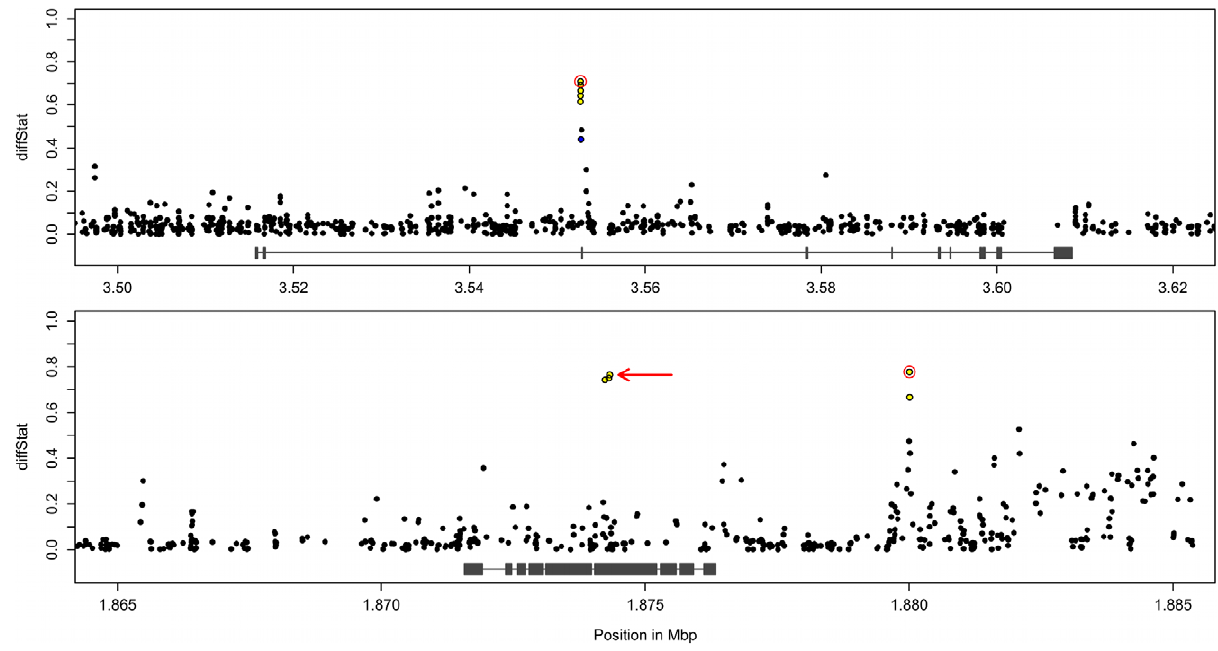
Figure 5. Fine-scale mapping of candidate causal variants. The diffStat is shown for each variant at each locus; black=nonsignificant variants, blue=FDR , 10%; purple=FDR , 5%; red=peak variants. Above: Eip63E; Below: dre4. For the candidate gene at each locus, the exons are shown as linked grey boxes; only one transcript is shown for simplicity. The arrow in B indicates a serine-tryptophan replacement discussed in the text.